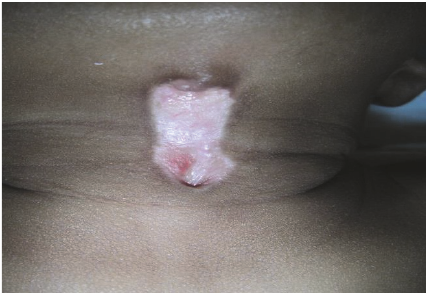
Figure 1: Clinical criteria of CMCC: superior nipple-like structure, inferior sinus, and atrophic skin in between.